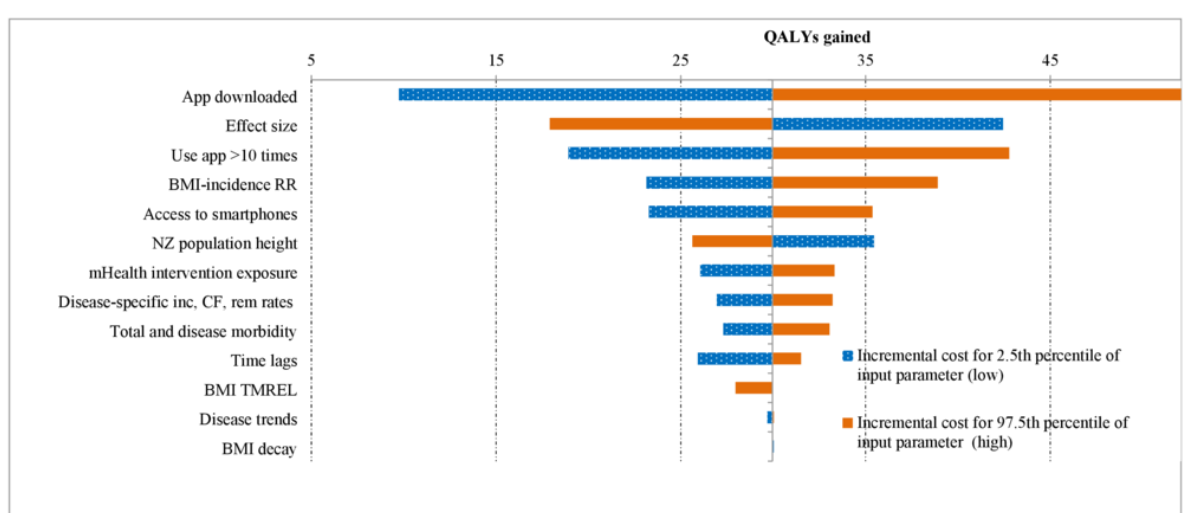
Figure 2. Tornado plot indicating which parameters drive uncertainty in the model results for health gain (in quality-adjusted life-years; QALYs) for the population. BMI: body mass index; CF: case fatality; inc: incidence; mHealth: mobile health; NZ: New Zealand; rem: remission; RR: relative risks; TMREL: theoretical minimum risk exposure level.